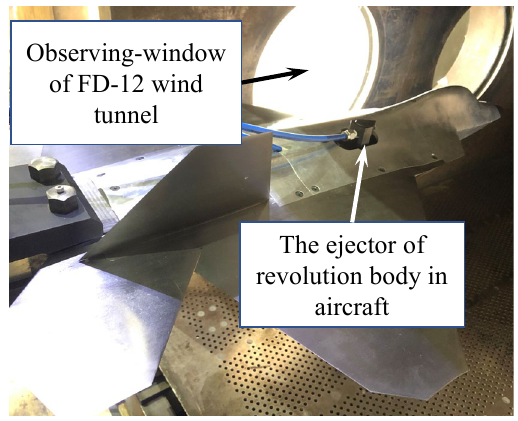
Figure 6. Test installation diagram.